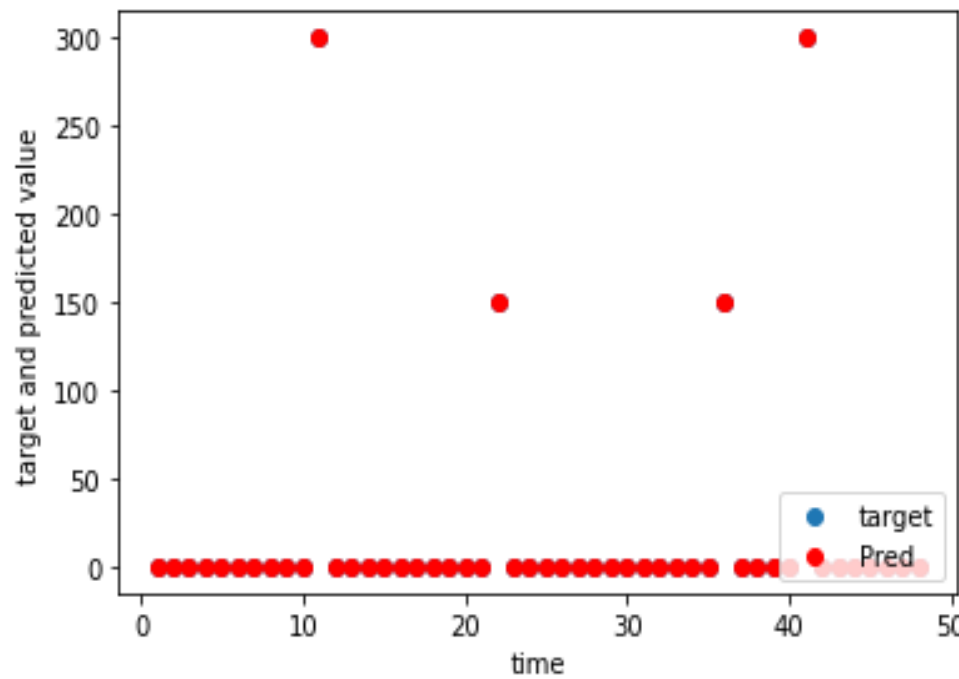
Figure 9. Charging demand prediction of a weekday for Hyljeveneentie.